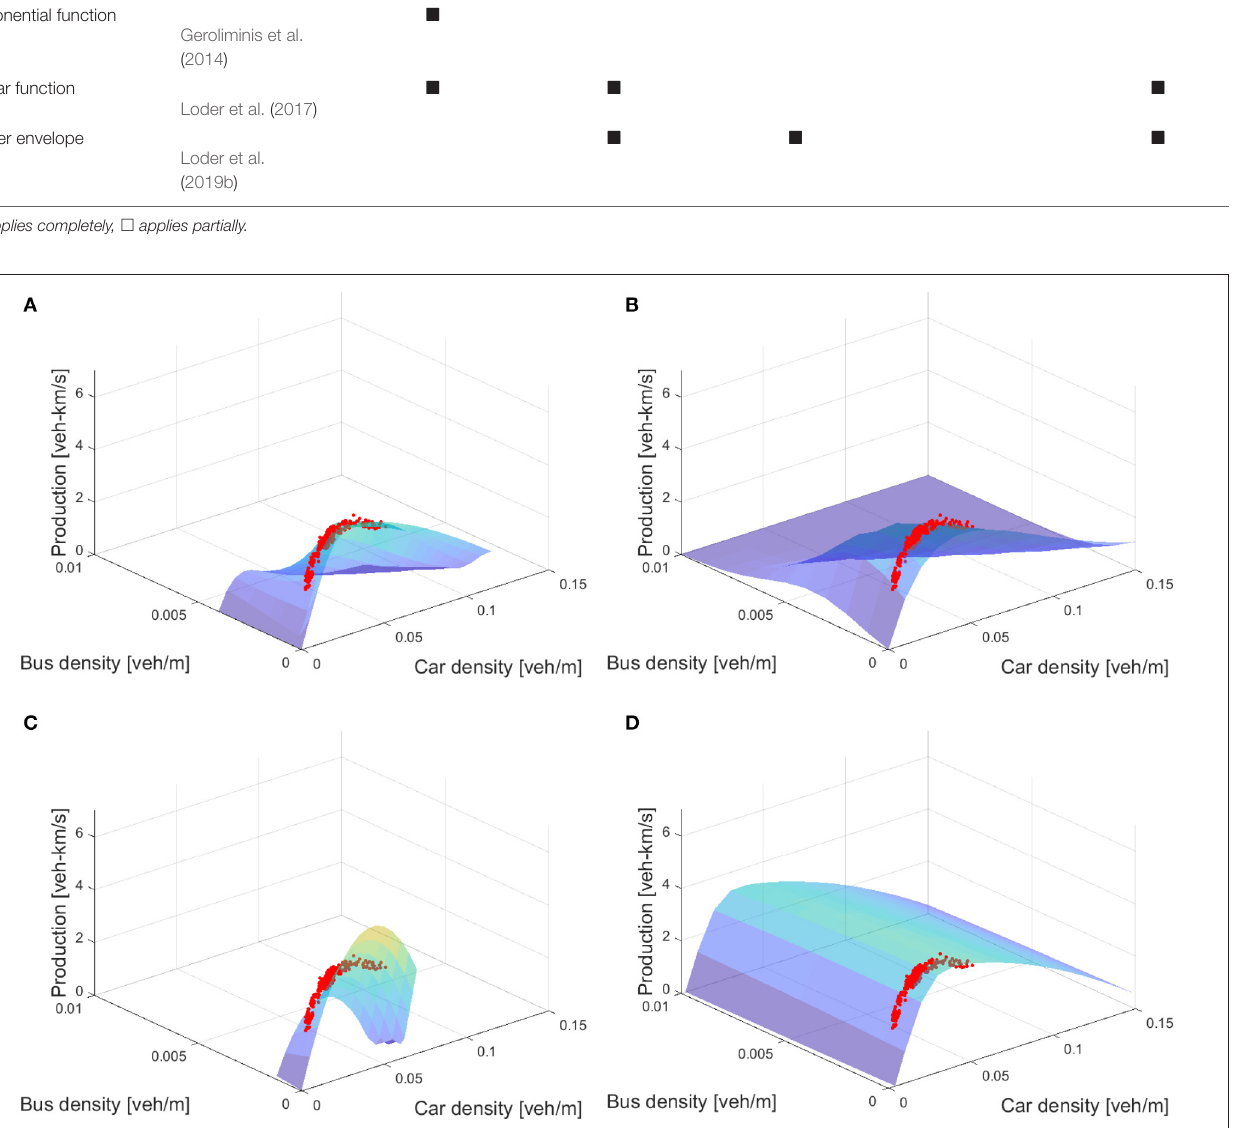
et al. (2019b). Figure 5A proposed vector-based approach 3D-MFD, Figure 5B the exponential function 3D-MFD, Figure 5C the linear model 3D-MFD, and Figure 5D the lower envelope 3D-MFD. Importantly, the 3D-MFDs